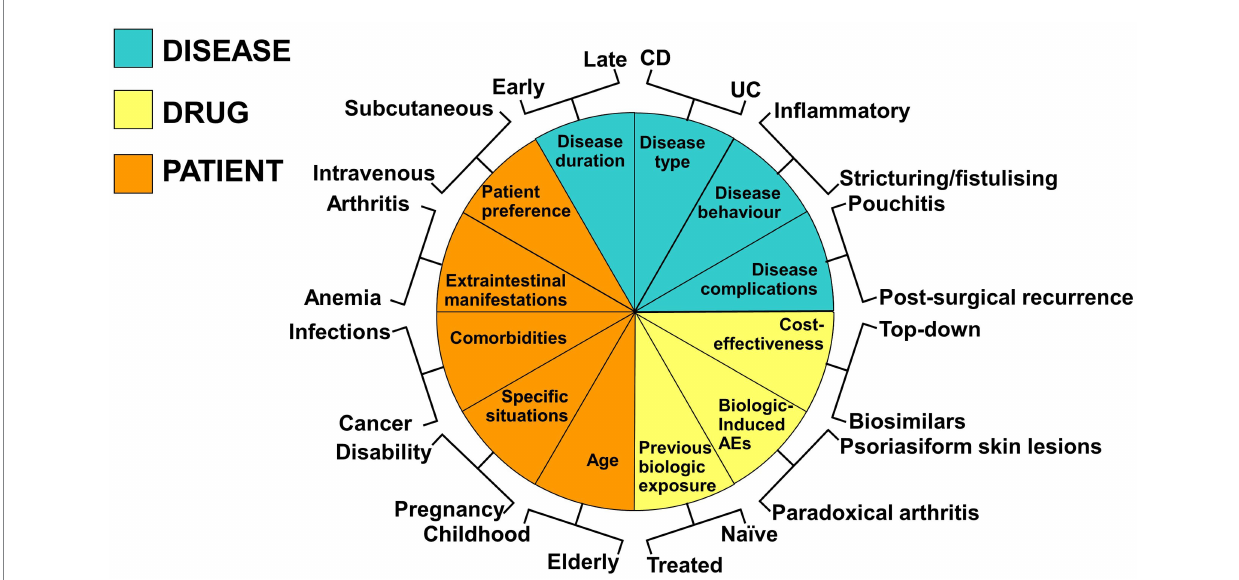
FIGURE 1 Schematic representation of disease-, drug-, and patient-related factors to be considered in the overall management of inflammatory bowel disease (IBD). The factors depicted in the Figure encompasses the four main domains of the 4P medicine, including prediction, prevention, participation, and personalization. Current guidelines do not comprehensively cover these aspects, that all pertain to an internal medicine setting. Indeed, many other variables not depicted in the Figure should also be considered and discussed with